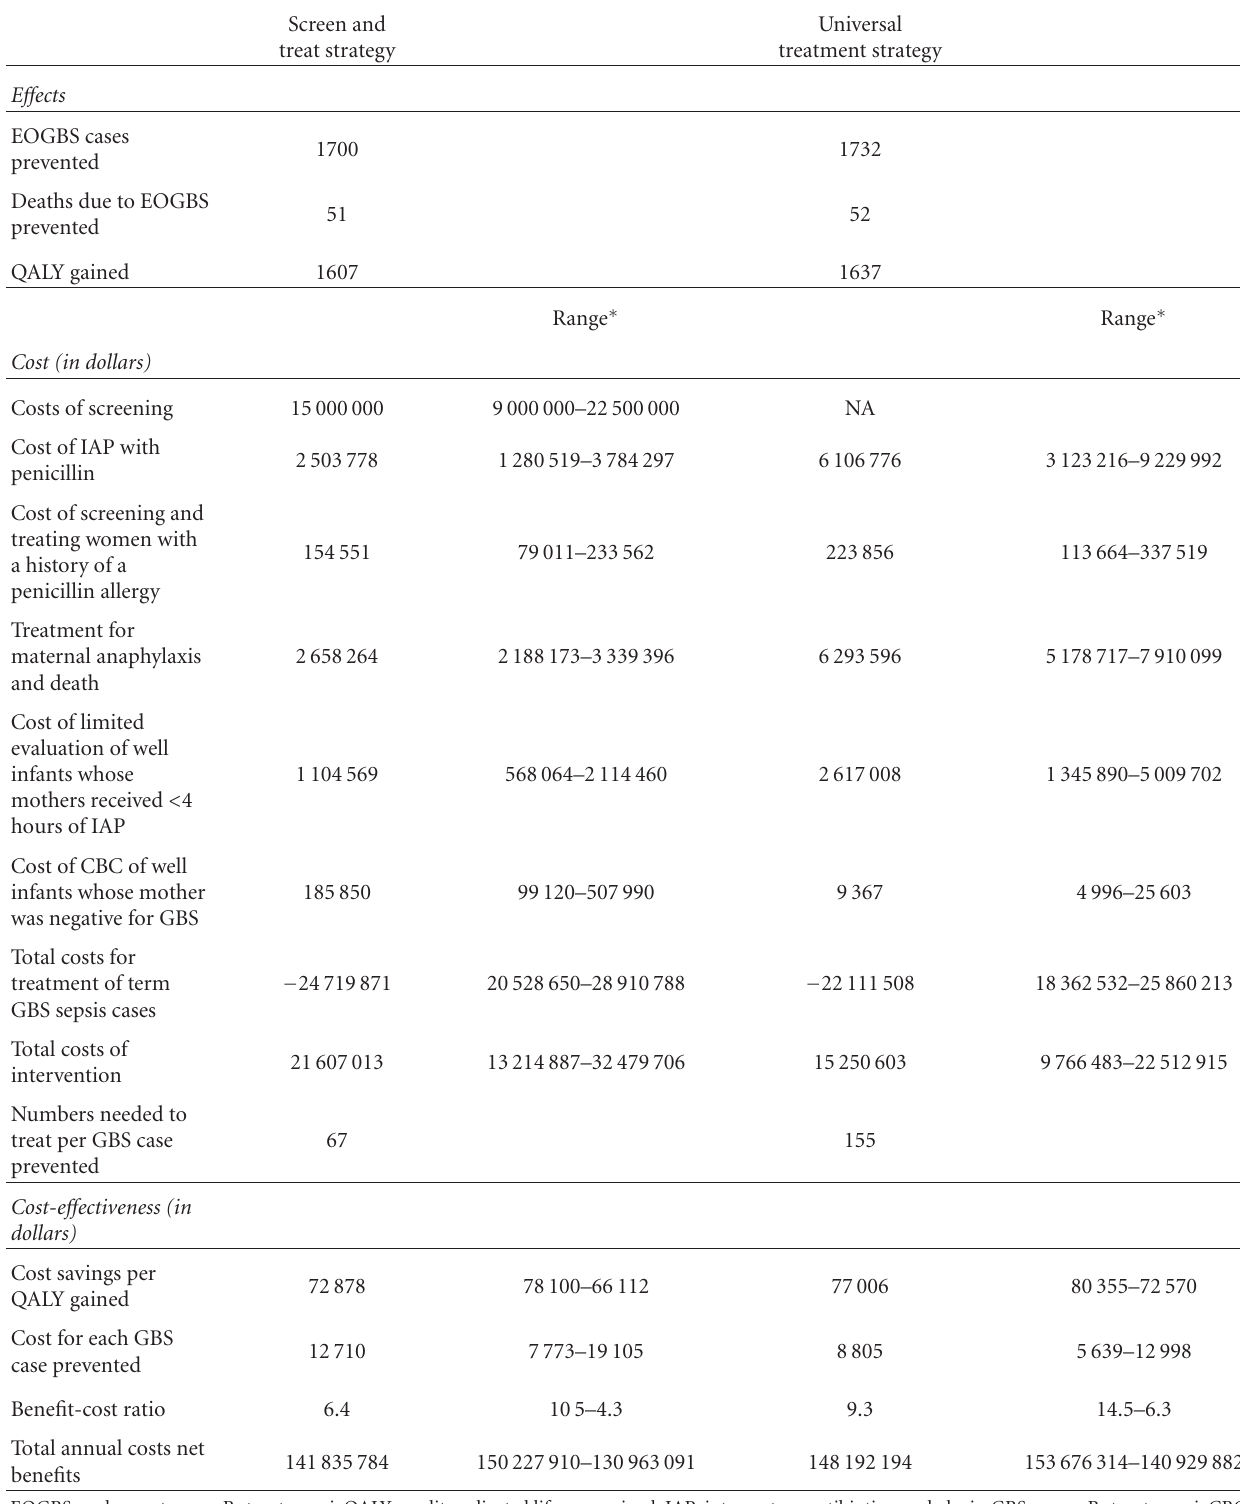
Table 3: Estimated e ff ects and costs (in 2008 USD) of the di ff erent treatment strategies compared with a situation without treatment for